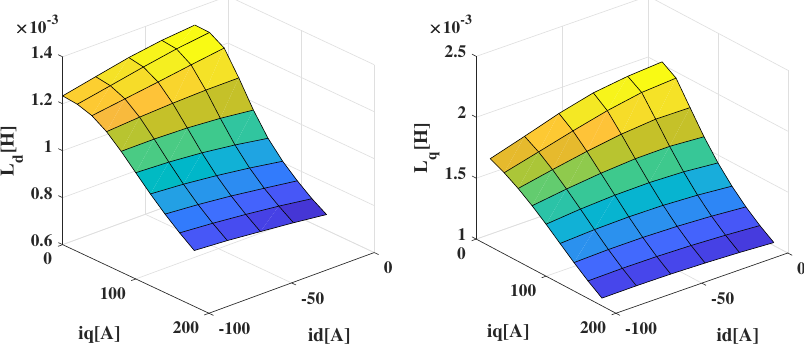
Figure 8. Inductance maps established through FEA. On the left the d-axis inductance and on the right the q-axis